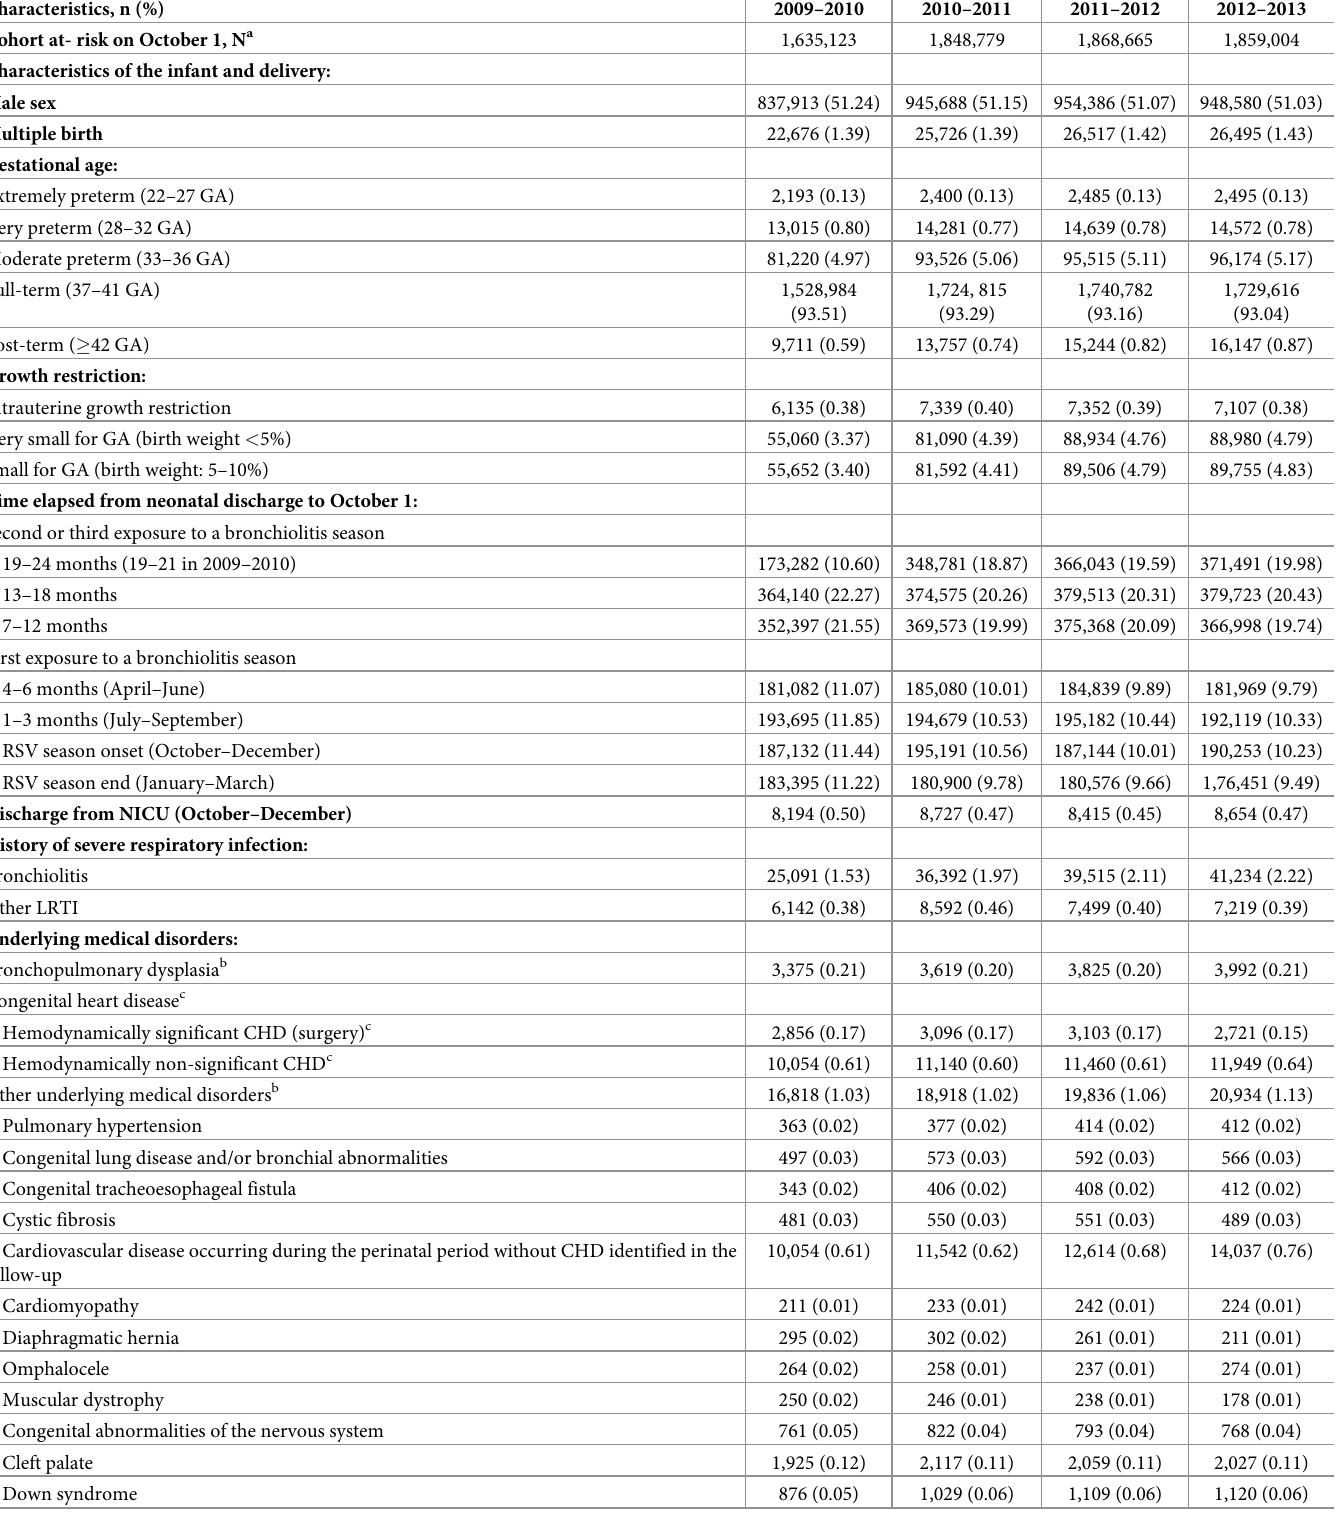
Table 1. Characteristics of infants and children < 2 years at-risk over four consecutive bronchiolitis seasons (N = 7,211,571). Characteristics, n